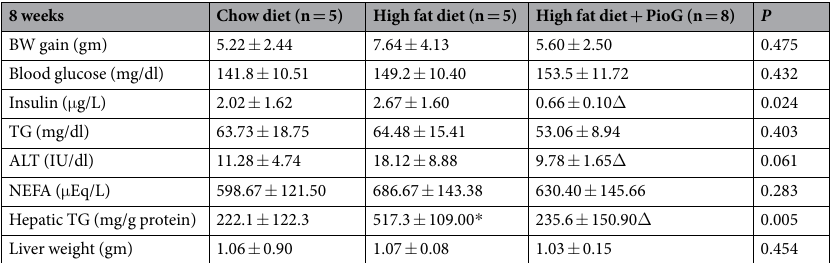
Table 1. Biochemical data among three groups. Values were indicated as means ± S.D.; ALT: alanine aminotransferase; NEFA: non-esterified free fatty acid; Hepatic TG: hepatic triglyceride content; PioG: pioglitazone. Kruskal-Wallis test among three groups and Student’s t test between two groups were used for statistical analysis; p < 0.05 indicated significant. * vs chow diet, Δ vs high fat